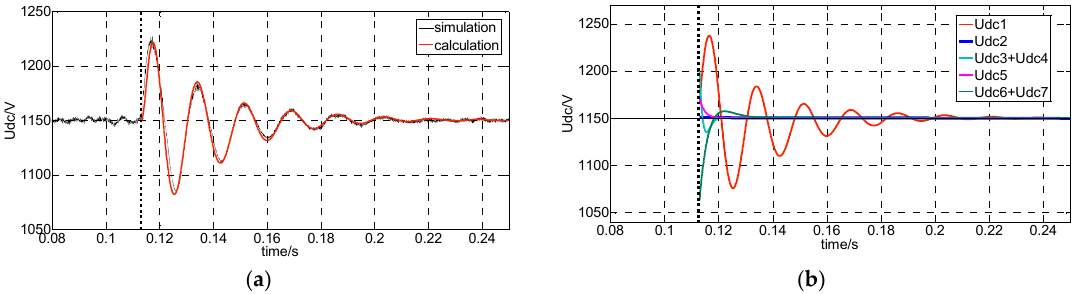
Figure 6. Comparison of DC bus voltage and decomposition of frequency components: ( a ) comparison between simulated and calculated waveform; ( b ) decomposition of frequency components.